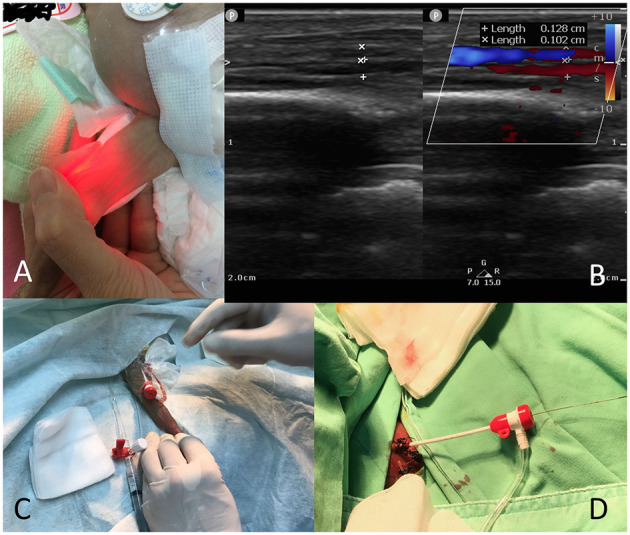
Preparation of venous cannulation. (A) Use of a transilluminator to identify the femoral vein location in a 533-g baby; (B) Use of ultrasound to identify the femoral vein in a 509-g baby; (C) A 4F sheath (femoral vein) in a 533-g baby; (D) A 4F sheath (umbilical vein) in a 478-g baby.